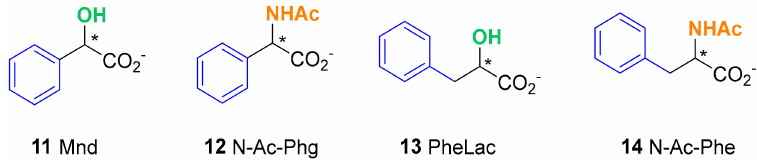
Figure 2. Structure of the anionic guests investigated in this study, used as TBA salts.